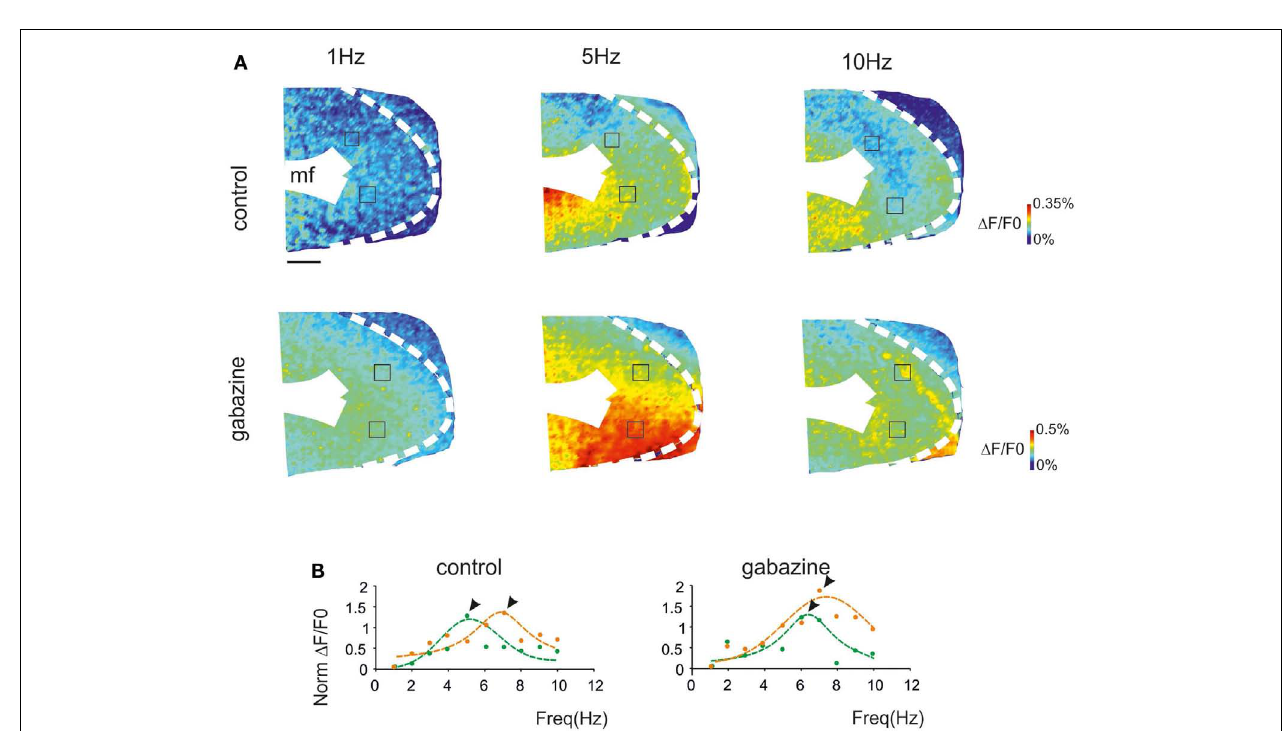
Scale bar 100 µ m. (B) The panels show the resonance curves corresponding to specific ROIs of the GRL indicated in (A) (squares).The data points show maximum responses either at 5Hz (green) or 7Hz (orange), both in control and after gabazine perfusion (arrowheads indicate points at the resonance frequency). Broken lines are single Lorentzian functions fitted to the points.